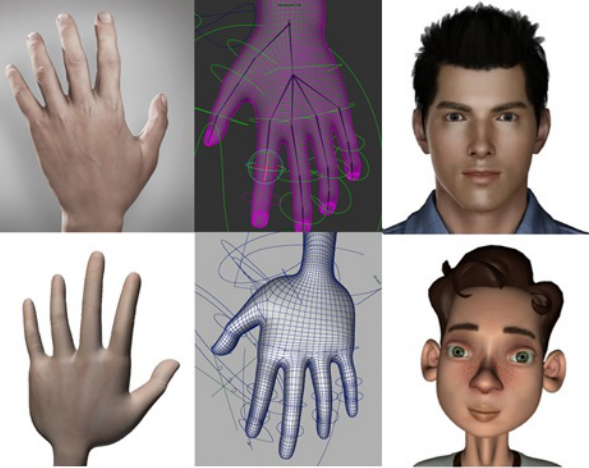
Figure 3. Clockwise: Rendering of realistic character’s hand;